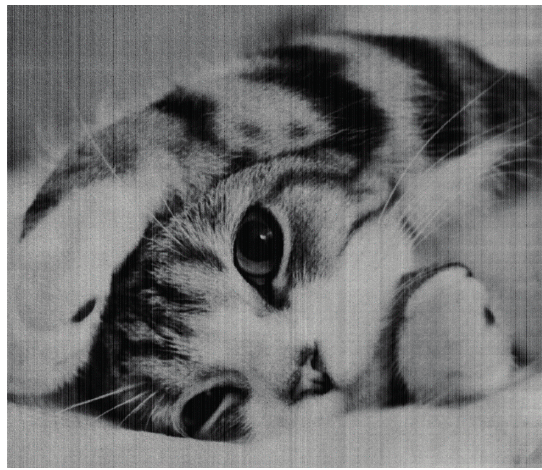
Figure 23. Sample image with 12-bit resolution.